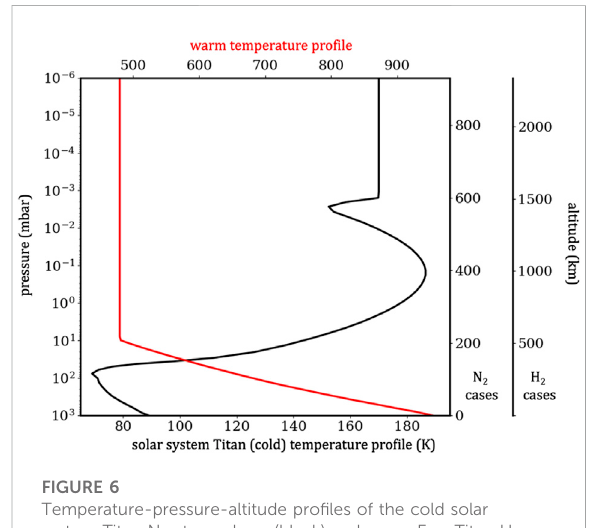
FIGURE 6 Temperature-pressure-altitude pro fi les of the cold solar system Titan N 2 atmosphere (black) and warm Exo-Titan H 2 atmosphere (red). Notice the altitude scale changes for the Exo- Titan, which is a result of the warmer temperature and puffy nature (large scale height) of H 2